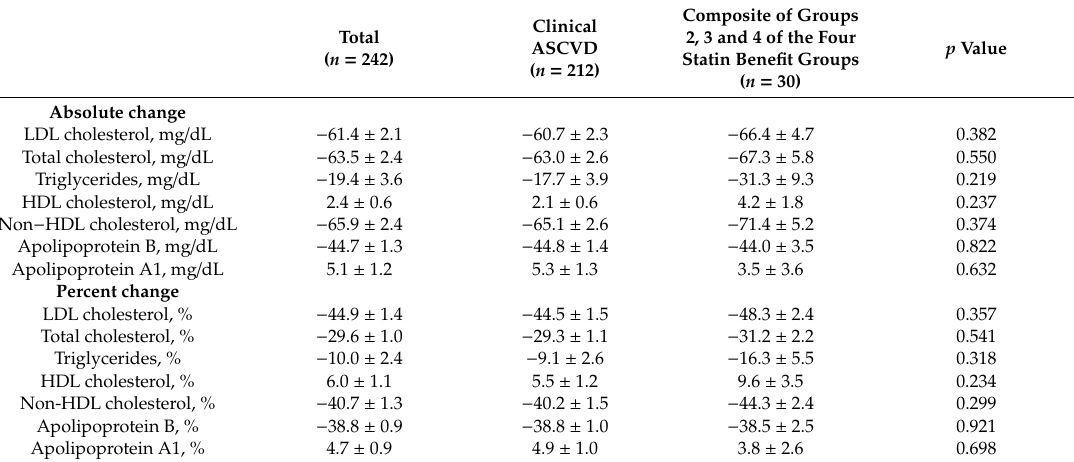
Table 2. Changes in lipid profiles as per ACC / AHA guidelines for the four statin benefit groups, by clinical atherosclerotic cardiovascular disease (ASCVD).